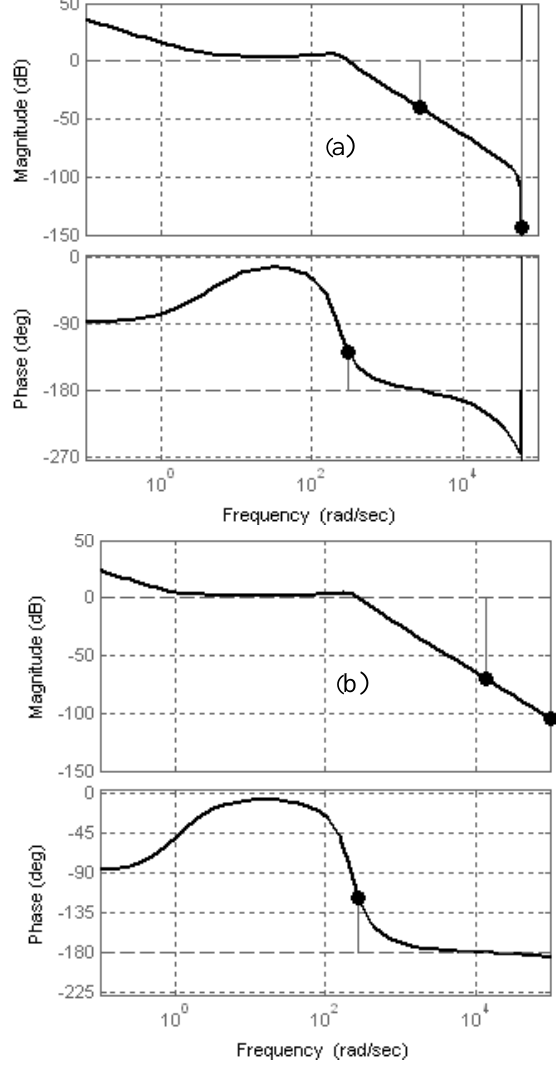
Fig. 12. Magnitude and phase response of the system for the (a) PI Controller and (b) proposed wavelet fuzzy Controller. Fig. 7. (a)-(c) shows the speed response of the induction motor started at no load with a set speed of 180 rad/sec.. It is clearly seen that the response of the wavelet-fuzzy based self tuning MR controller outperforms conventional PI and fuzzy-PI Fig. 11. Comparision of the speed response for a step change in load for PI controller, Fuzzy-PI controller and the Proposed Wavelet-Fuzzy Controller.